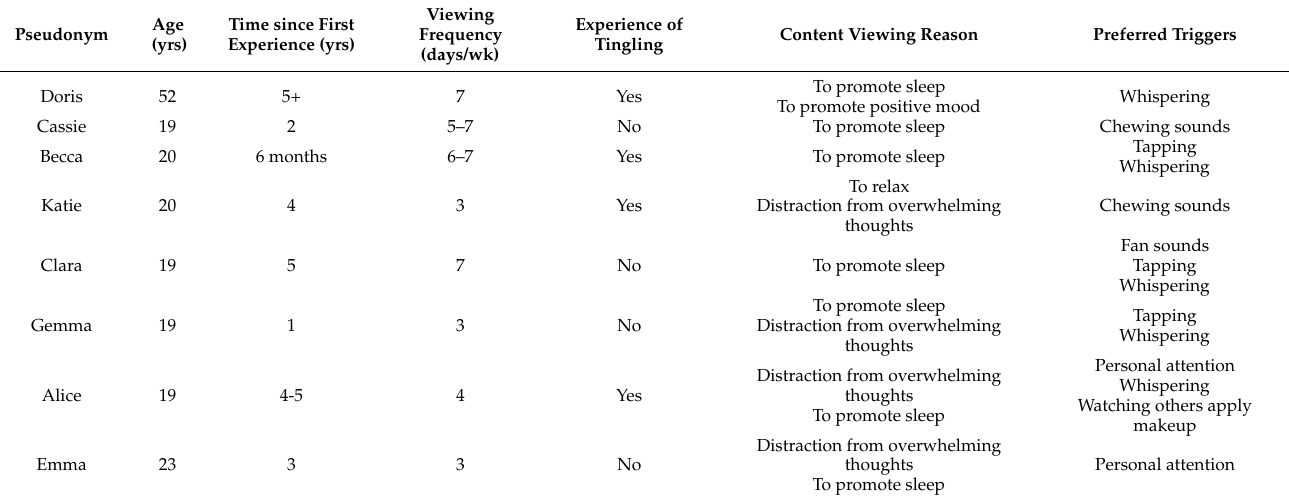
Table 1. Participant demographic information and characteristics of ASMR